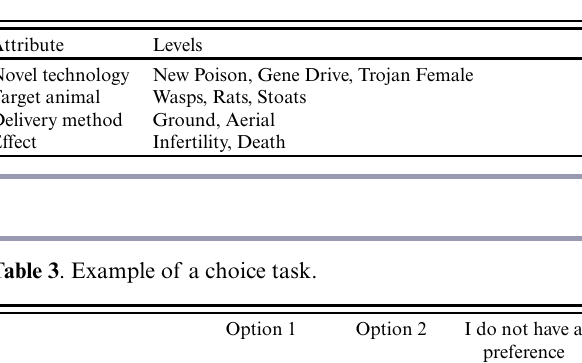
Table 2 . Attributes and levels in the choice experiment.